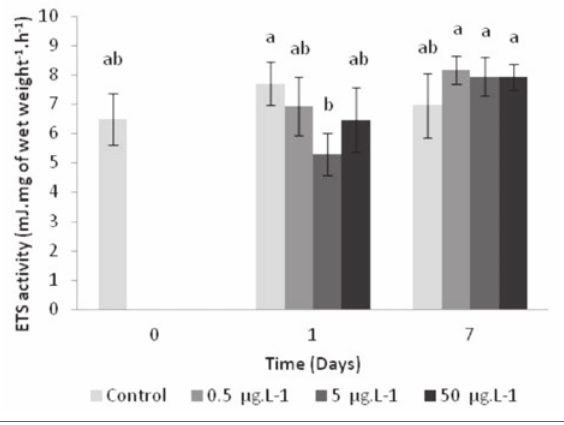
Figure 4. Electron transport system activity during ethofumesate 17°C exposure in white muscle of roach. Different letters indi- cate significant differences